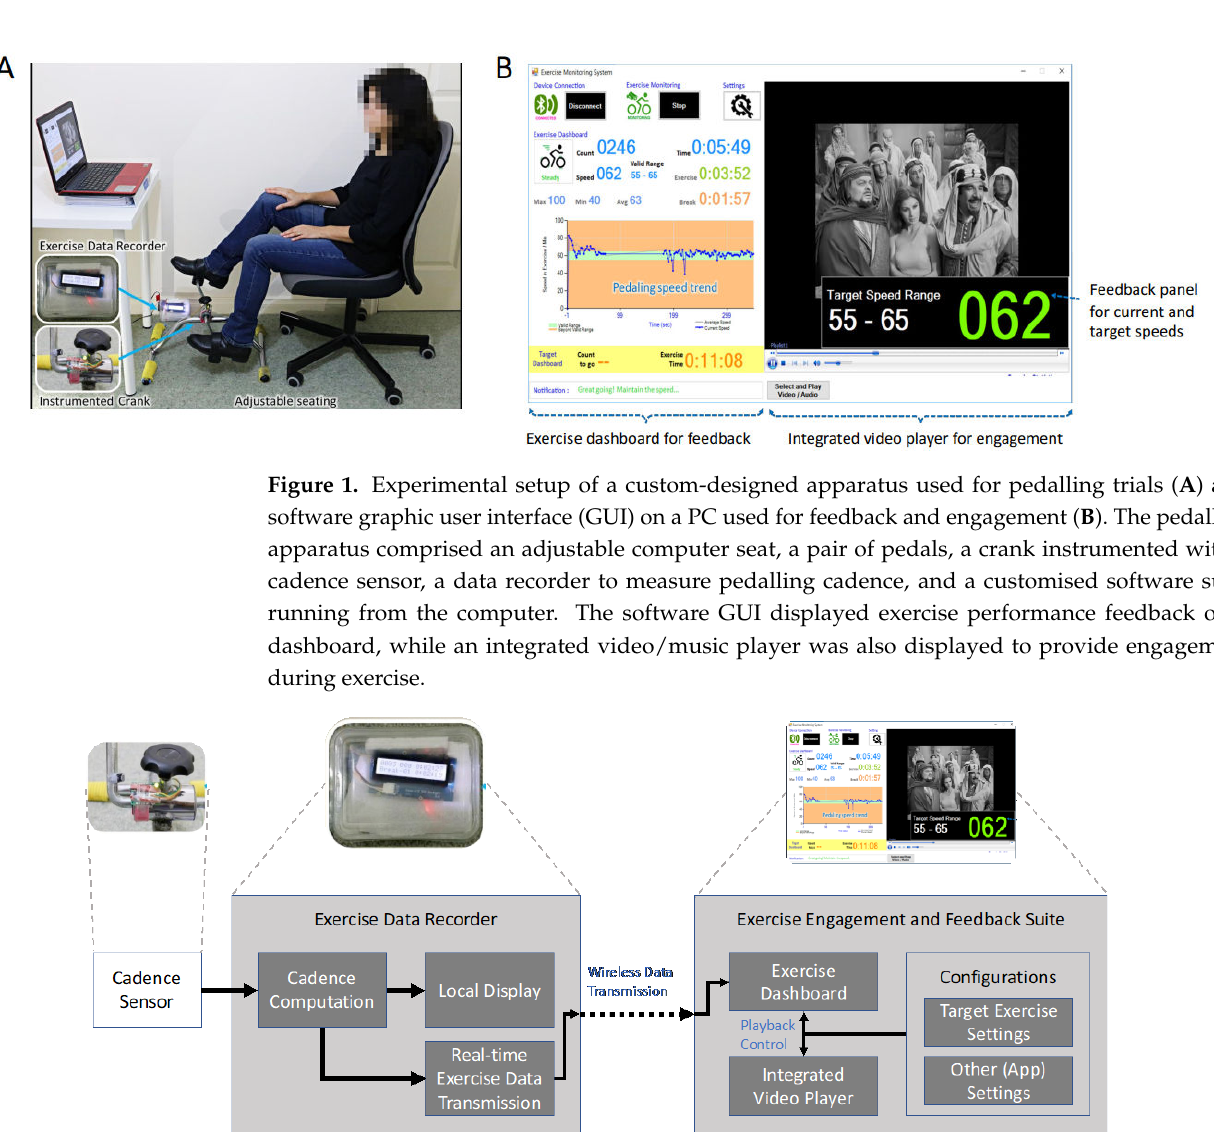
Figure 2. Data workflow for the pedalling apparatus, which integrated cadence data recorded from a cadence sensor that was output to a local display and transmitted wirelessly to a PC via an exercise data recorder. The software-based exercise engagement and feedback suite featured exercise per- formance data visible on a dashboard, an integrated video player used for engagement, as well as a configurations menu used for programming the task